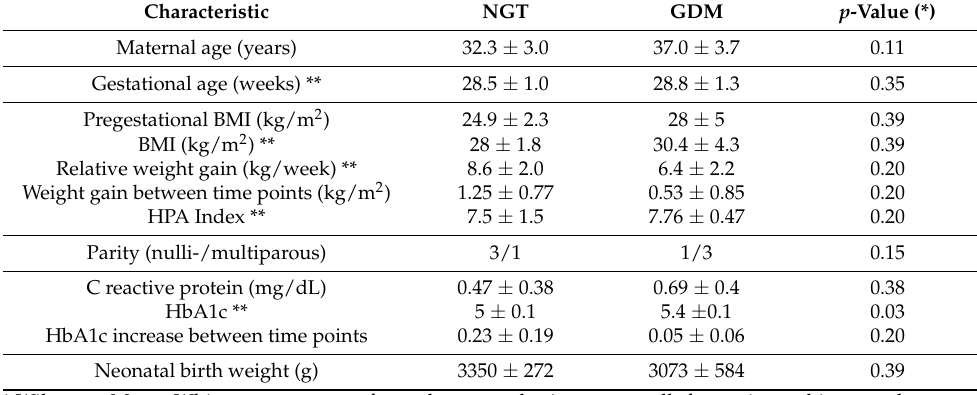
Table 1. Characteristics of study participants. Data are given as mean ± standard